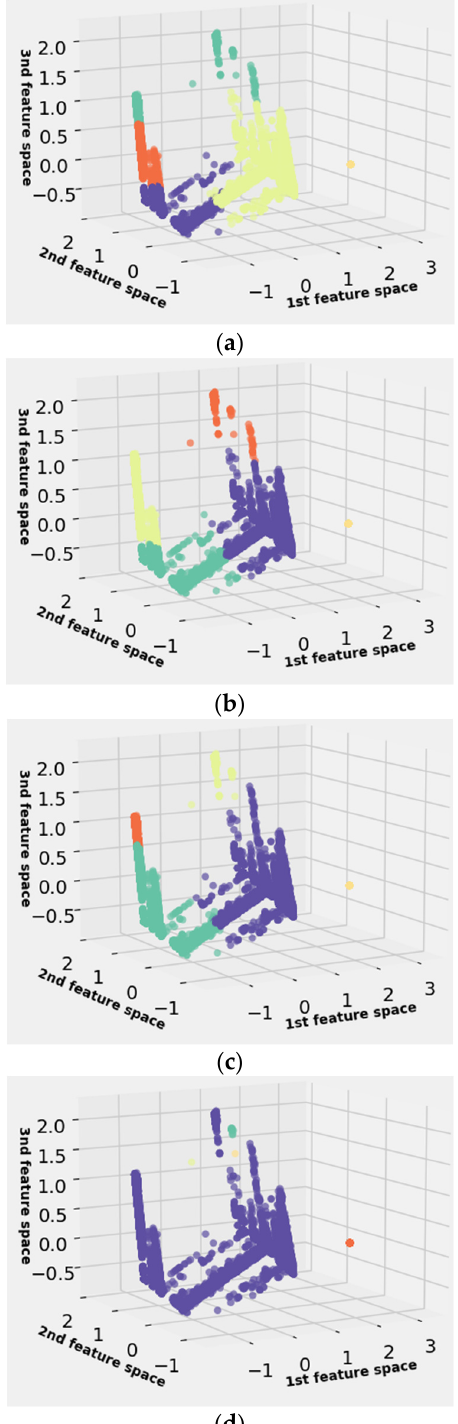
Figure 6. Hierarchical clustering results of the four linkage measures. ( a ) Ward method. ( b ) Complete method. ( c ) Average linkage. ( d ) Single linkage.